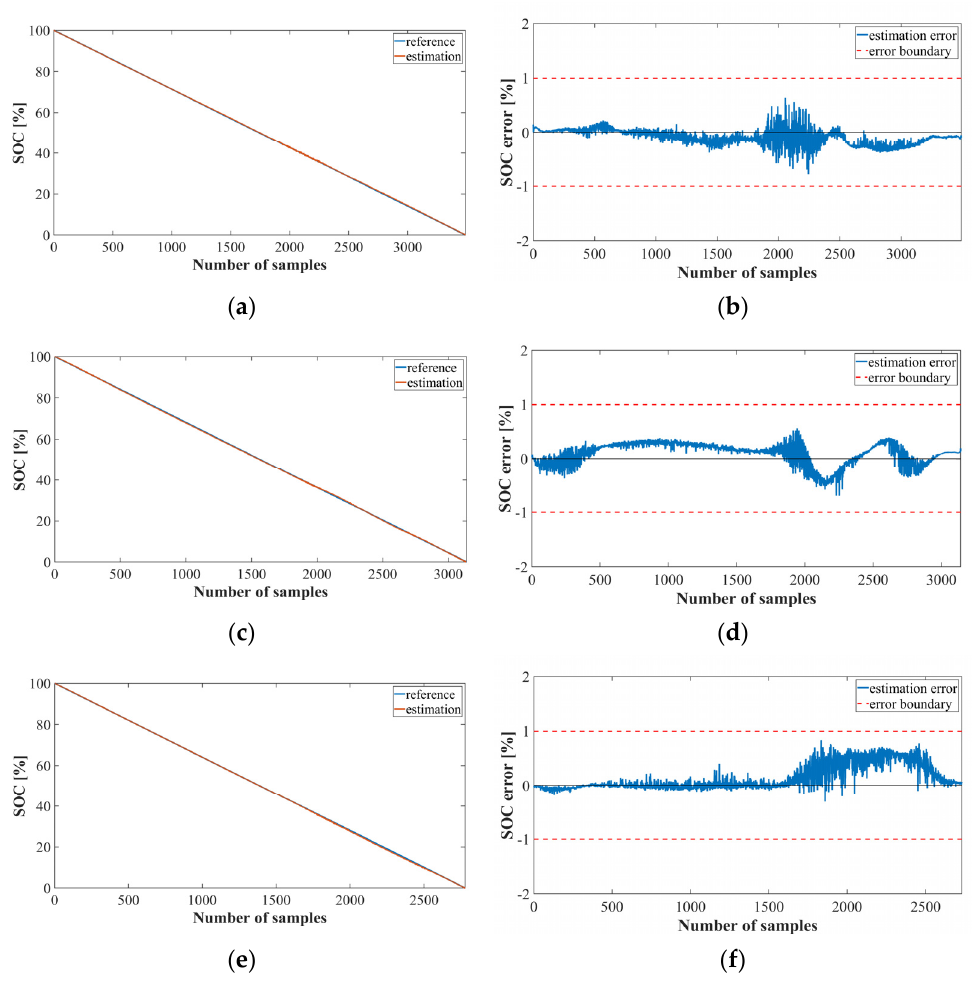
Figure 12. SOC estimation results for Method 2 using the LSTM (Oxford dataset): ( a ) SOC estimation result; ( b ) error at cycle 6; ( c ) SOC estimation result; ( d ) error at cycle 28; ( e ) SOC estimation result; ( f ) error at cycle 70.